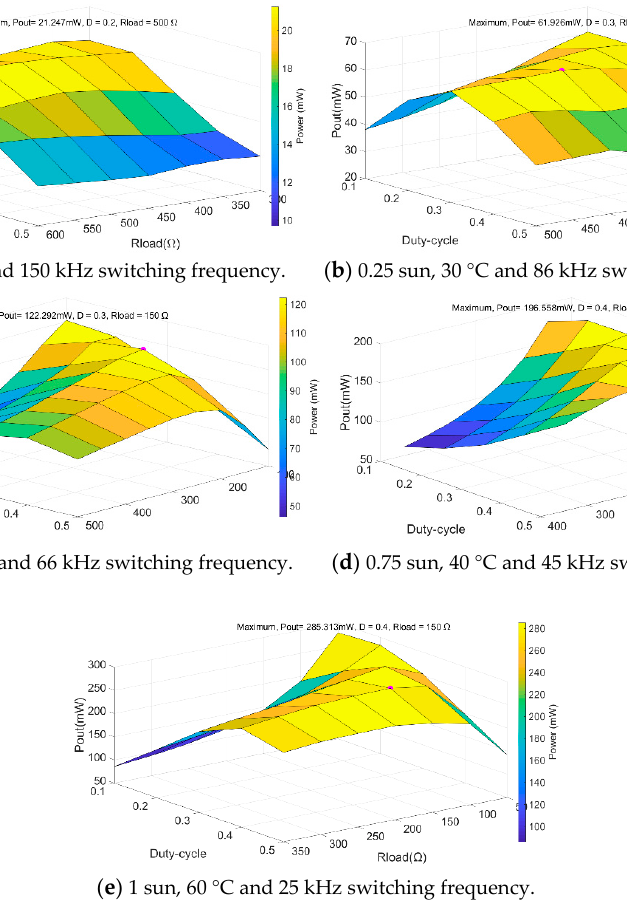
Figure 13. DC/DC output values dependent on different input and configuration conditions.